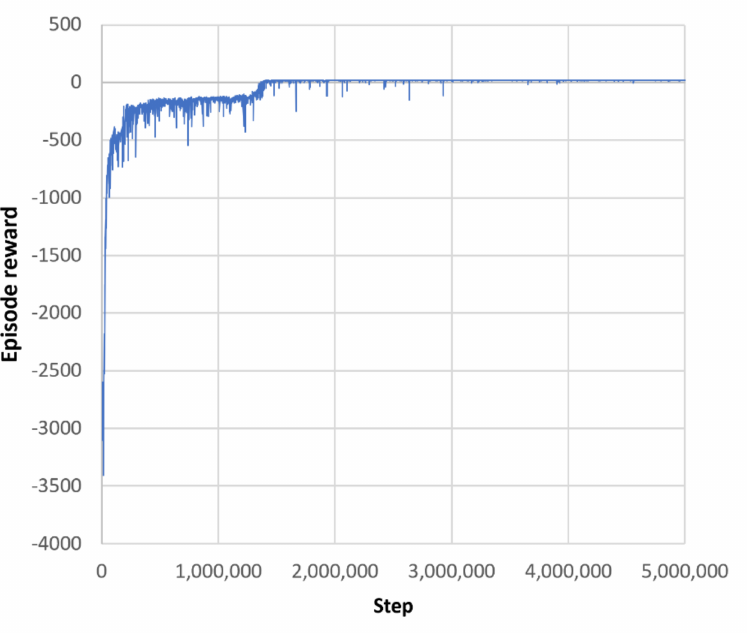
Figure 8. Episode reward during training the RL